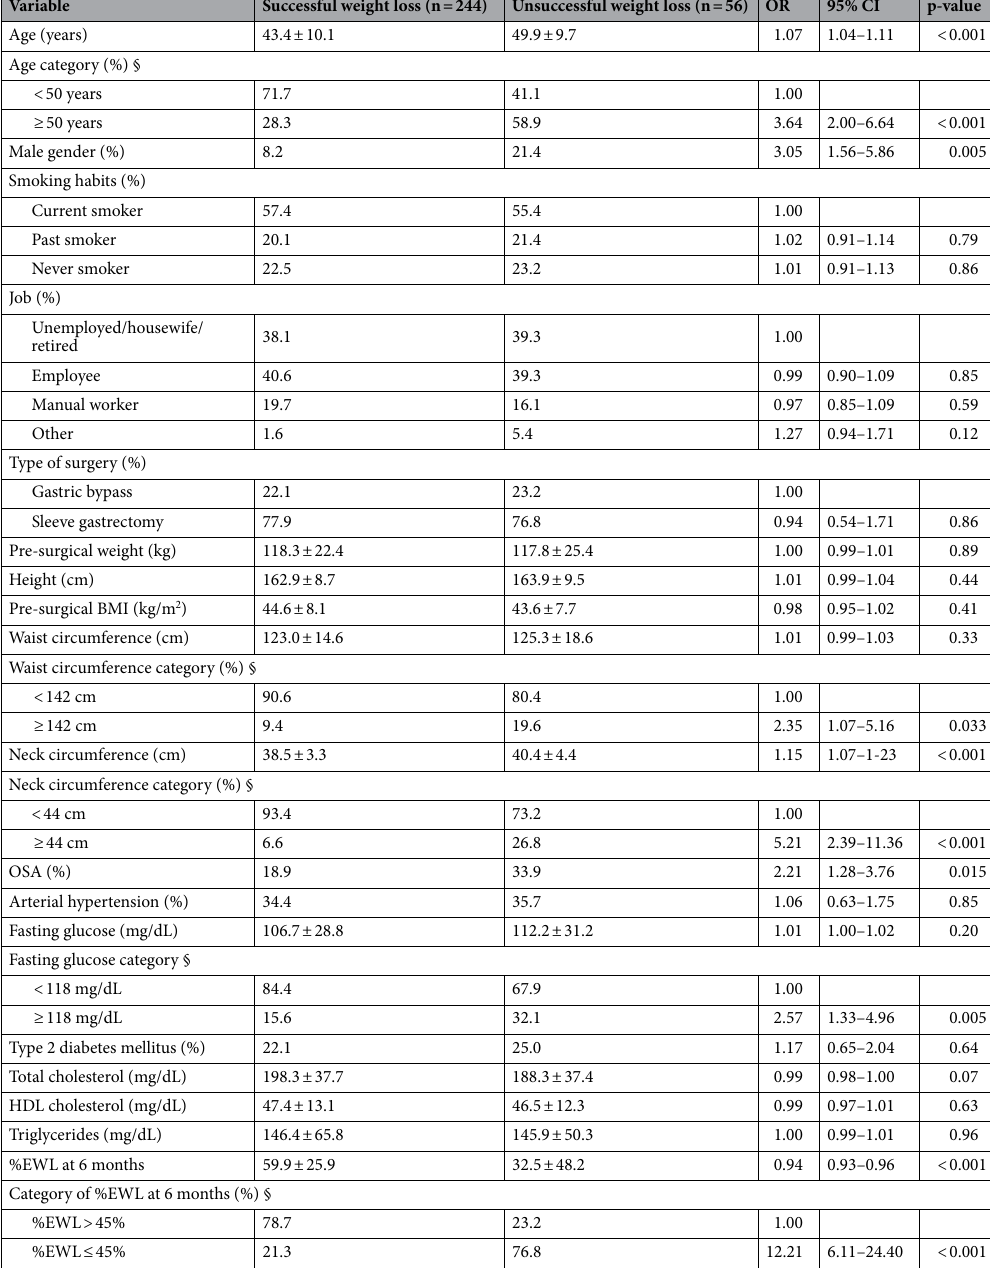
Table 1. Association of pre-surgical and early post-surgical data with BS failure (defined as %EWL < 50% at 2 years), analyzed through univariate logistic regressions. § Cut-off derived through CACC discretization algorithm. BMI body mass index, BS bariatric surgery, CACC Class-Attribute Contingency Coefficient, CI confidence interval, EWL excess weight loss, HDL high-density lipoprotein, OR odds-ratio, OSA obstructive sleep